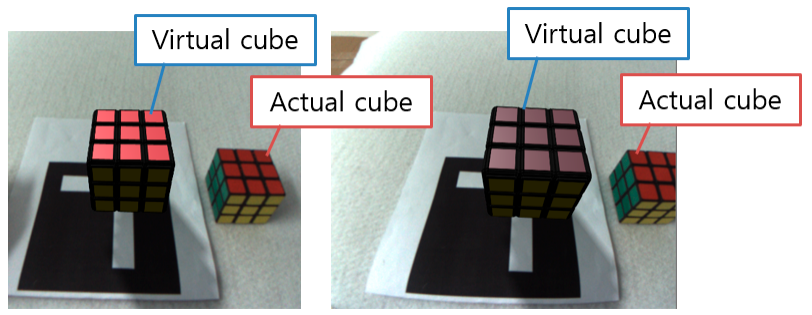
Figure 12. Experimental environment for color perception. The color of the virtual cube was selected by comparing the color of the actual cube. The image on the left represents the color at the beginning of the experiment, and the image on the right shows the process of matching by the subject.